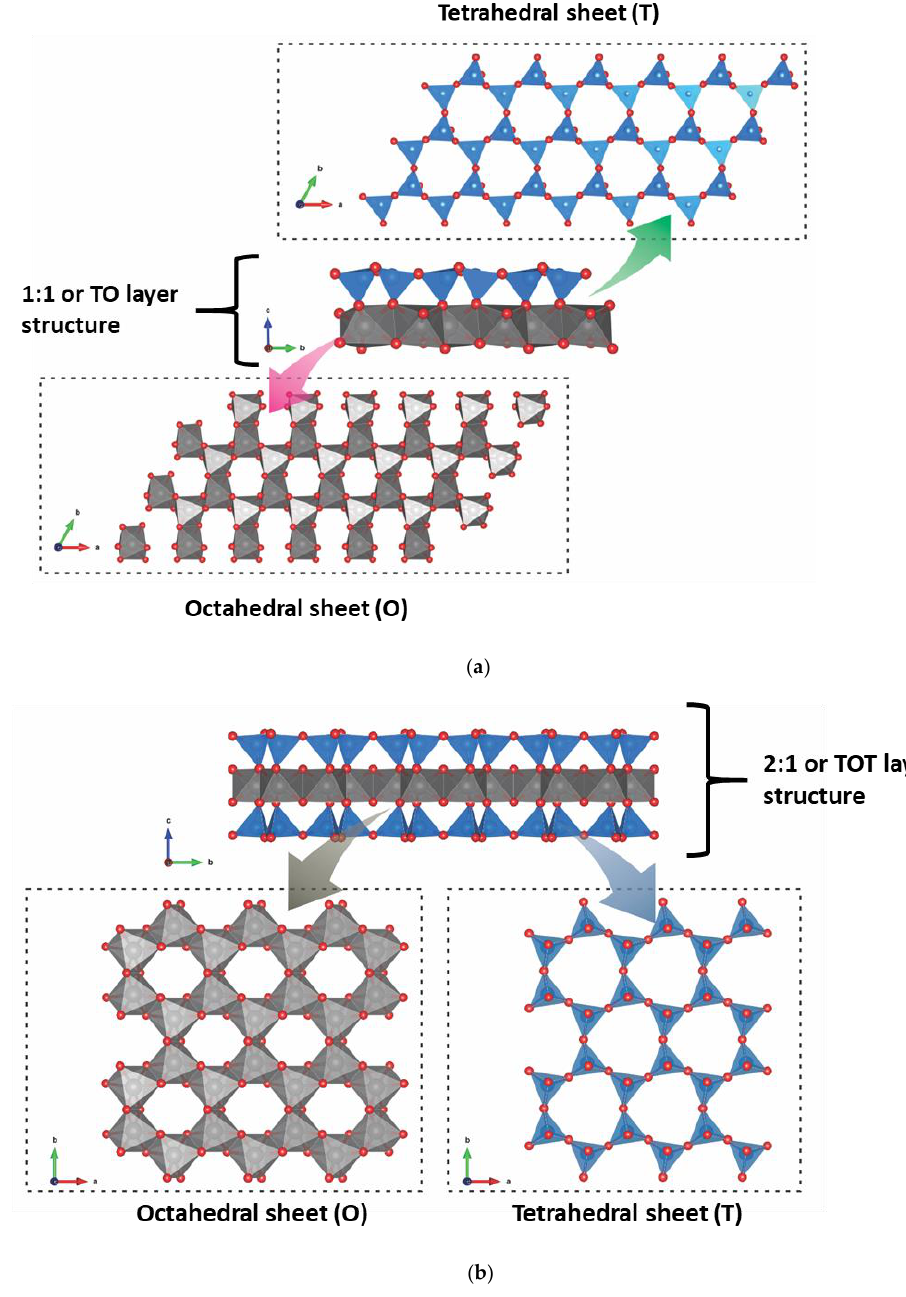
Figure 2. Tetrahedral and octahedral sheets and ( a ) TO and ( b ) TOT layers of the clay mineral structures. Both structures (TO and TOT) can be charge neutral. In this case, they do not have intercalated cations to counterbalance the global lamellar charge, where the superposi- tion of layers can occur through chemical interactions of different natures [15]. Different degrees of isomorphic substitution can occur for the derived clay mineral groups in the T and O sheets of the layers structure. For example, the tetrahedral sheet contains Si 4+ par- tially substituted by Al 3+ or Fe 3+ cations. In the octahedral sheet, high charge cations are substituted by cations with charges lower by one, such as Al 3+ by Mg 2+ , Fe 2+ or Mg 2+ by Li + . As a consequence, the layers are negatively charged. Cations counterbalance negative charges in the interlayer space to maintain global electric neutrality [14]. As observed, the TO or 1:1 layer structure comprises a tetrahedral sheet linked to an octahedral sheet. In contrast, in the TOT or 2:1 type layer structure, an octahedral sheet is sandwiched between two tetrahedral sheets. A surface of the layer in a 1:1 layer structure is constituted by the basal oxygen of the tetrahedral sheet. The opposite surface is con- stituted by the oxygen of the octahedral sheet, mainly OH. In the 2:1 layer structure, the two surfaces are constituted by the basal oxygen of the opposing tetrahedral sheets [16]. The adsorption capacity is the competence of clay minerals to interact with dis- solved substances through surface forces. There is an increase in the concentration of this substance at the adsorbent interface, and physical and chemical interactions can exist by ionic exchange. The cation exchange capacity (CEC) is defined as the ability of clay min- erals to retain cations in the interlamellar spacing, which is directly related to the nega- tive charge of the layers. Among several clays and clay minerals, some are used in the studies covered in this review. Smectites have a structure in planar layers of 2:1 (TOT) type, and the lamellar layer charge varies from 0.2 to 0.6 per half-cell unit. Montmorillonite (Mt) is the most widely used clay mineral belonging to this group. Mt is the main component of bentonites (mineral constituted pr edominantly by ≥ 50% smectite) [17]. In smectites, Si 4+ and Al 3+ ions occupy the tetrahedral sites, while Al 3+ and Mg 2+ occupy the octahedral sites and